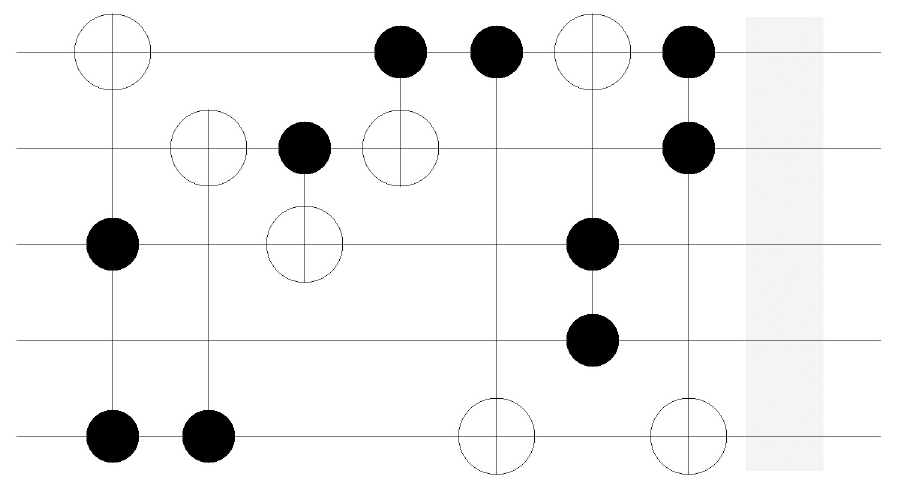
Fig 18. Resulting circuits of No. 18 4gt4_v1 with varying N